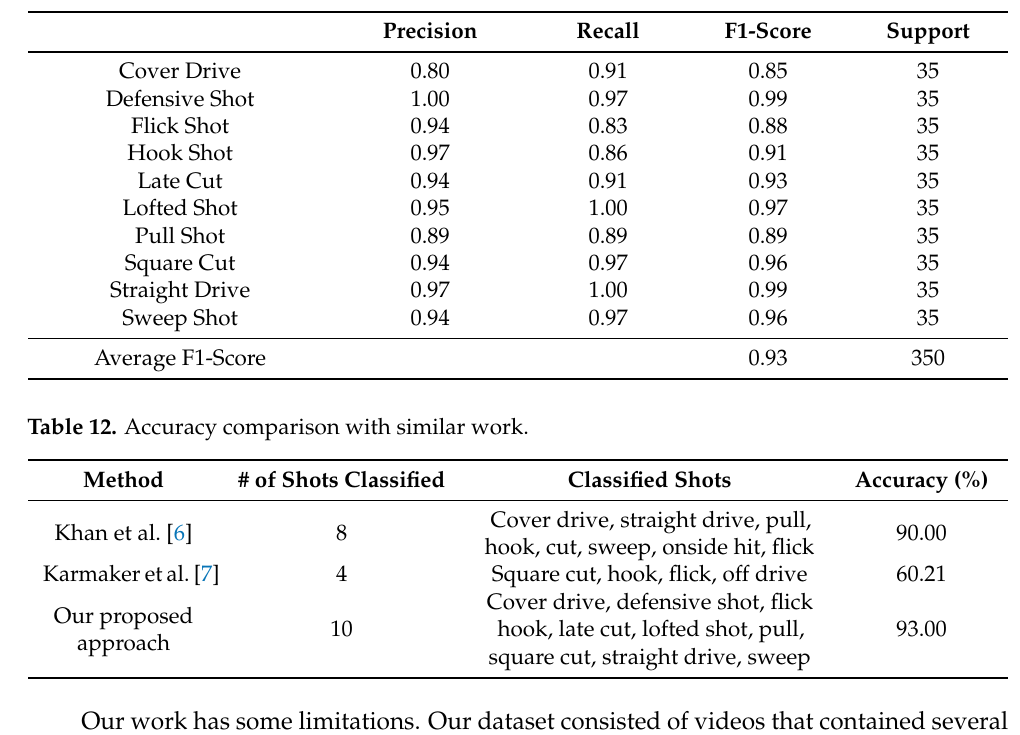
Table 11. Classification report for Model 2.